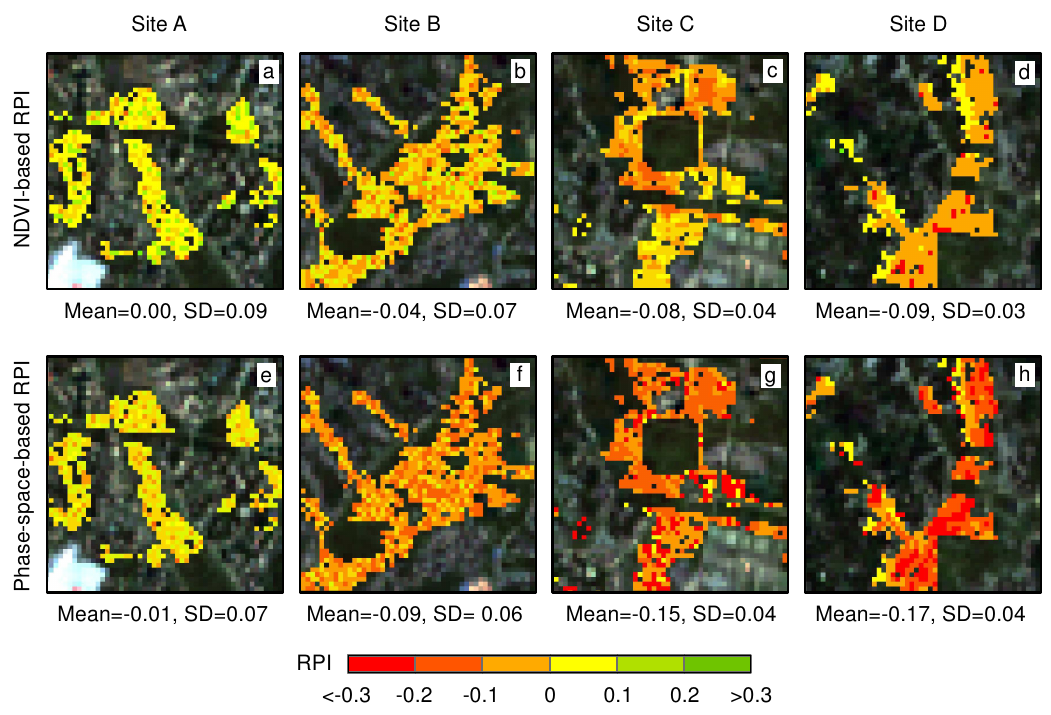
Figure 8. Spatial distributions of the mean values of ( a – d ) the NDVI-based RPI and ( e – h ) the phase– space-based RPI during the period 2013–2017.